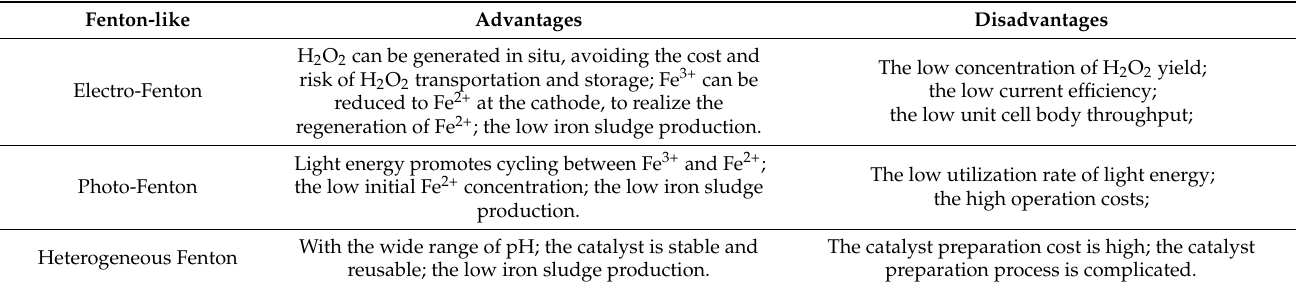
Table 4. The advantages and disadvantages of Fenton-like